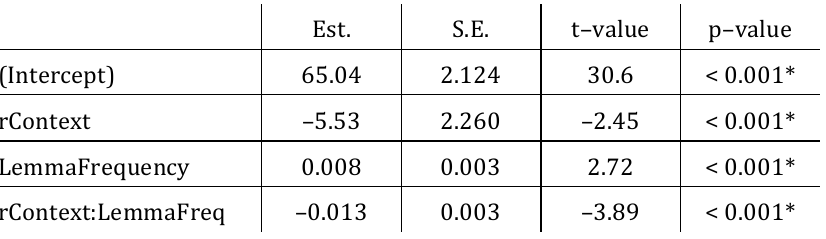
Table 3: Mixed-effects model for